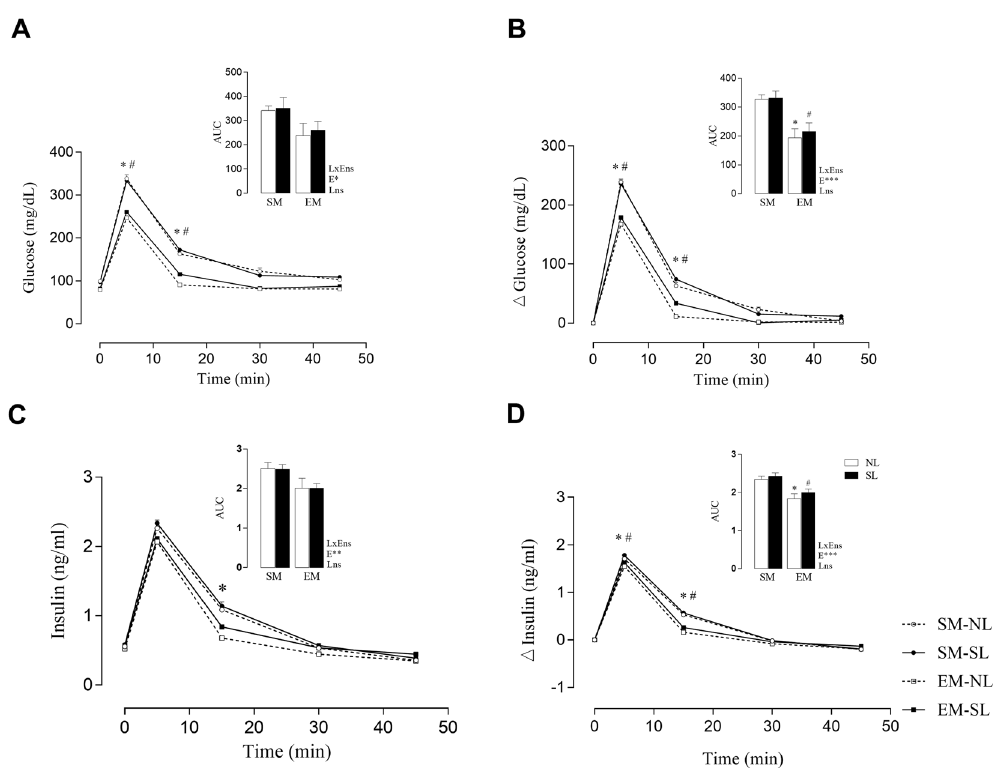
Figure 2. Effect of low intensity physical exercise training on glucose and insulin in mothers during the ivGTT. The upper panel represents the area under the curve (AUC). ( a ) plasma glucose, ( b ) plasma insulin,( c ) increments ( Δ ) of plasma glucose and ( d ) increments ( Δ ) of plasma insulin after weaning until LD21 (n = 10–12 per group). LxE, interaction between the exercise factor and the litter factor; E, exercise factor and L, litter factor; * p < 0.05 and *** p < 0.001 by Student’s t test. And **** p < 0.0001 , each time points of the plasma glucose and insulin during ivGTT, was calculated by repeated measures